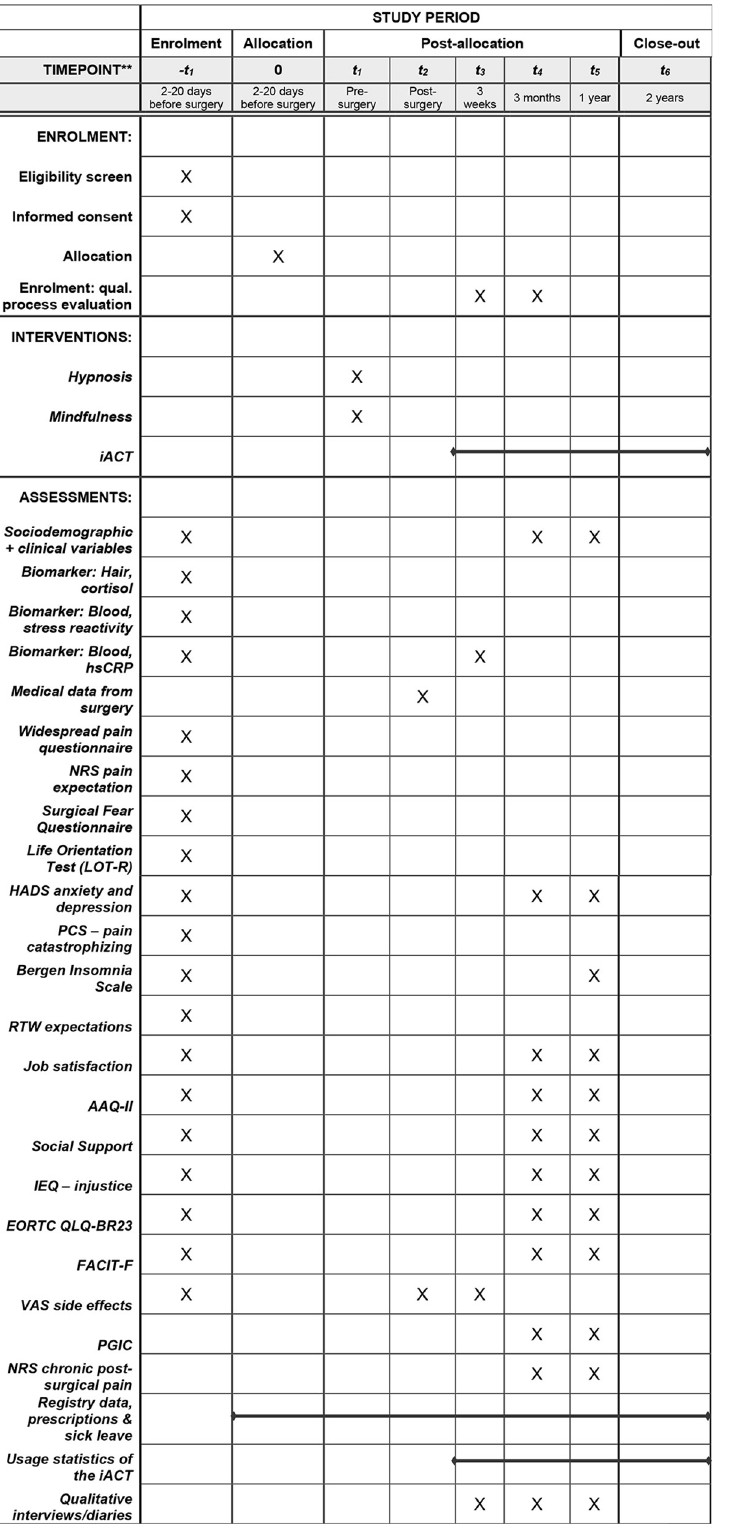
Fig 1. Schedule of enrolment, interventions, and assessments.